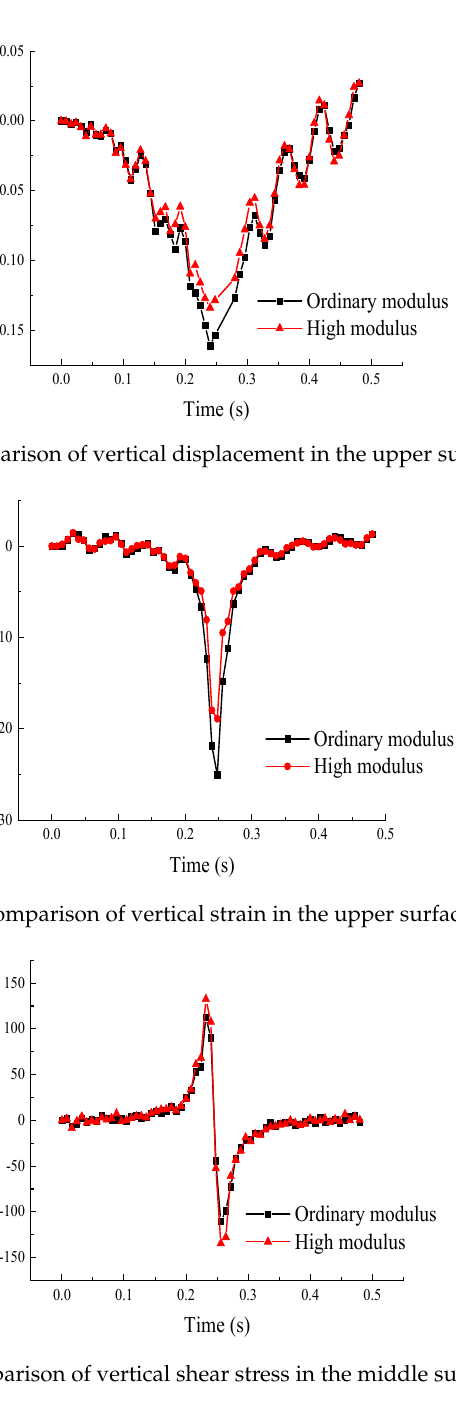
Figure 3. Comparison of vertical stress in the upper surface layer.